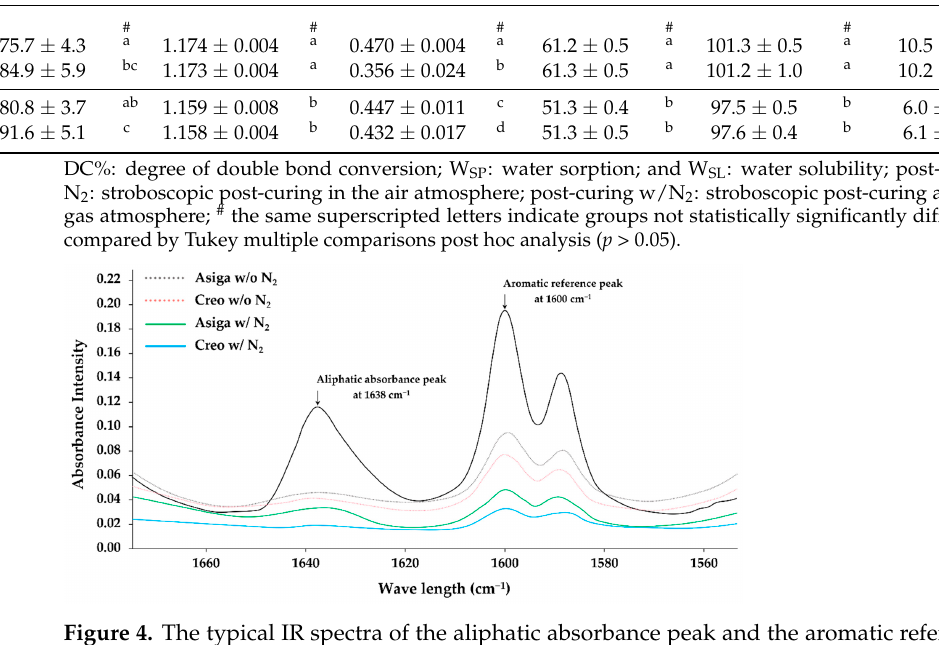
Table 3. Mean values and standard deviations of DC%, size of 3D microlayer structural unit, water sorption, and water solubility, and results of 1-way ANOVA statistical analysis.